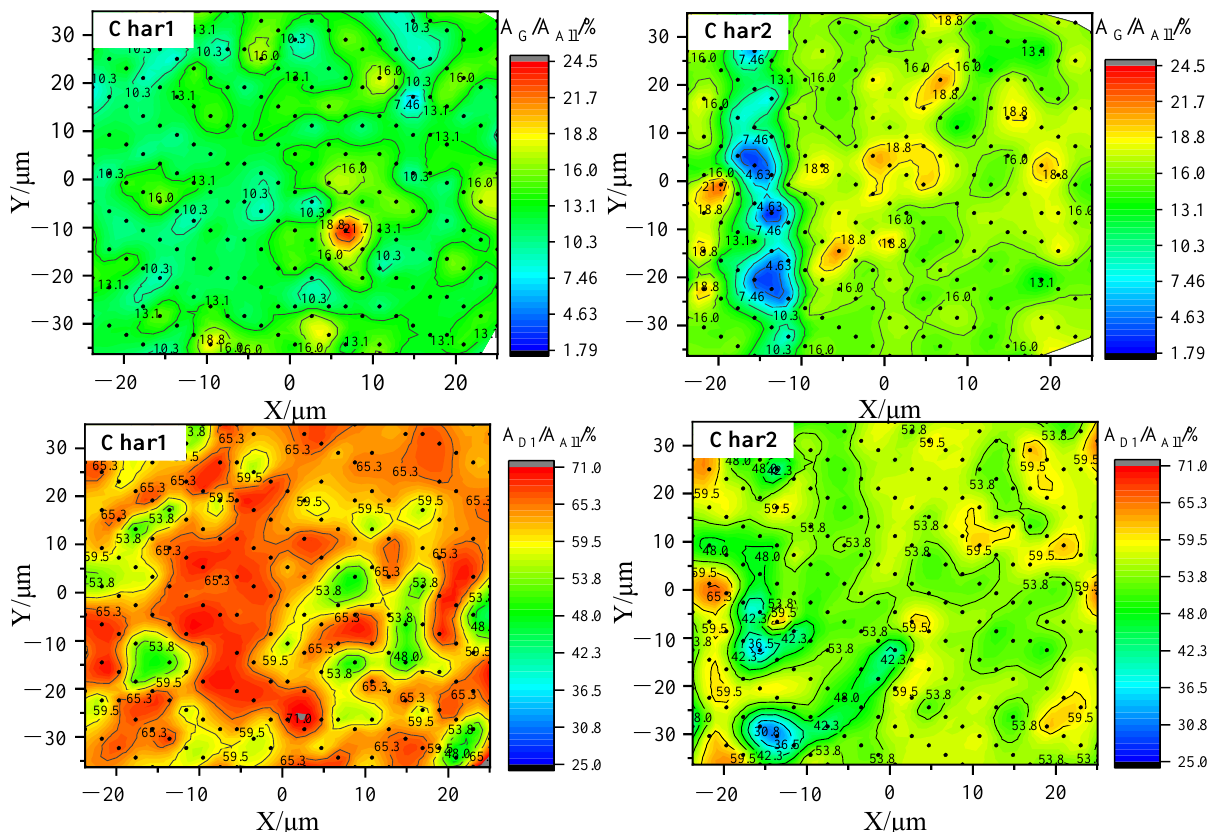
Figure 9. Two-dimensional contour maps of the characteristic parameters A G /A All and A D1 /A All of char1 and char2.